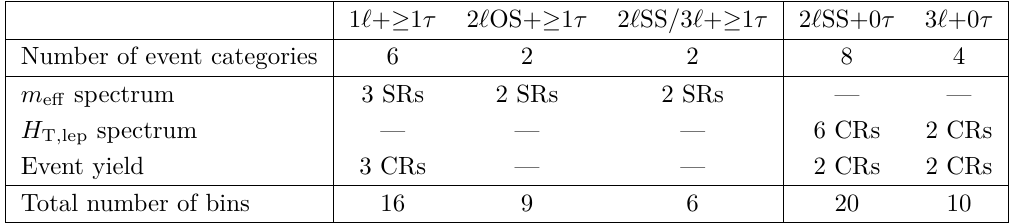
Table 8. Summary of the event categories per channel, discriminating variables per event category, and number of bins used in the statistical